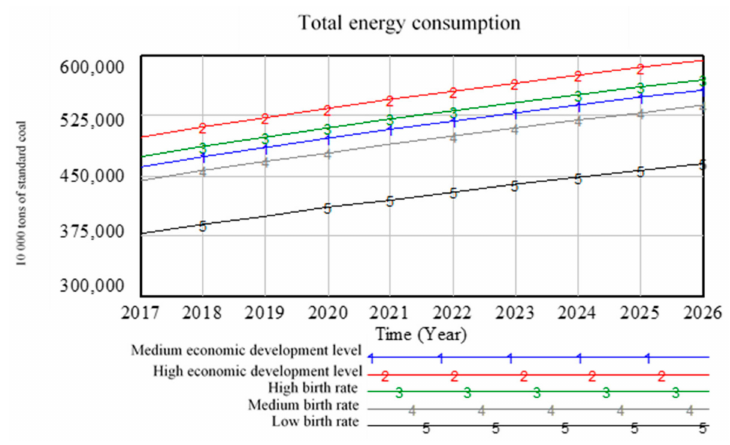
Figure 8. Scenario prediction curve for total energy consumption.